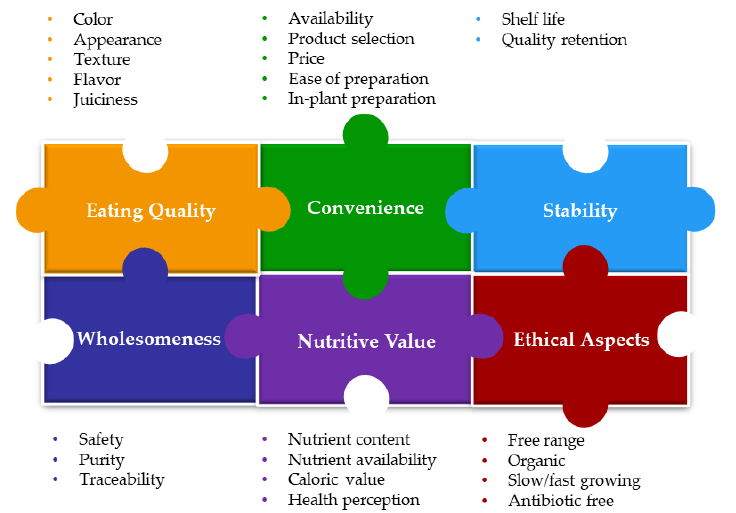
Figure 1. Example of interrelationships between factors that contribute to meat quality considering the perspectives of the producer, processor, and consumer. Note: as discussed in the text, the im- portance of the different factors depends on the industry